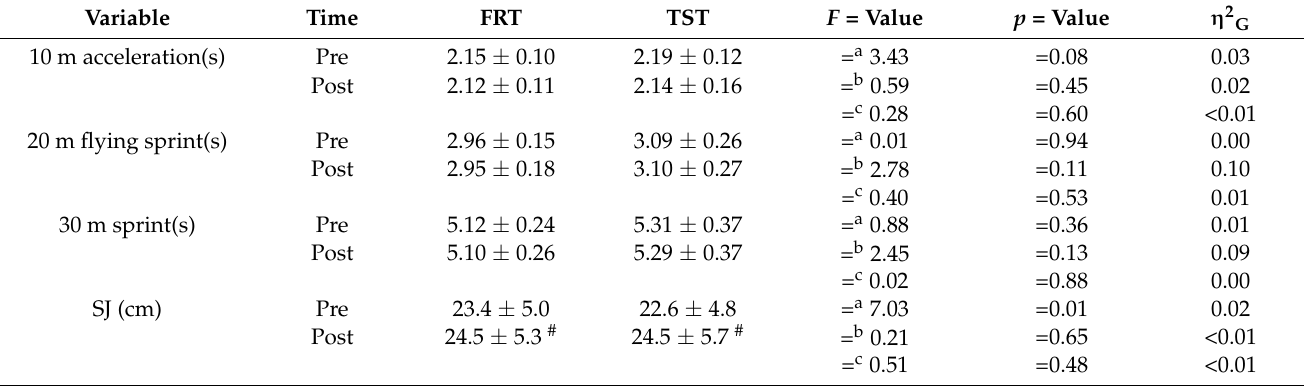
Table 2. Sprint and jump characteristics for both training